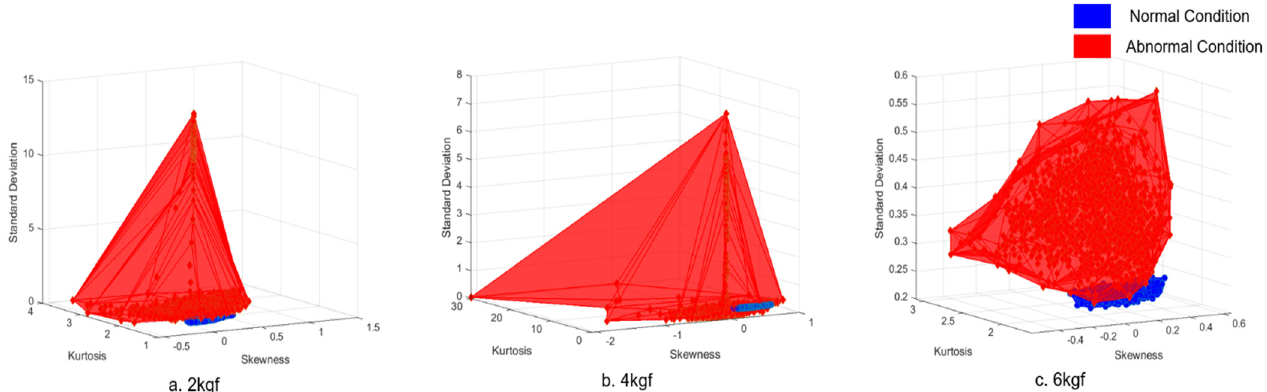
Figure 6. Volume comparison of normal and abnormal condition data: ( a ) Operating tension of 2 kgf; ( b ) Operating tension of 4 kgf; and ( c ) Operating tension of 6 kgf. Table 7. Doctor blade tilting fault diagnosis based on smart data.